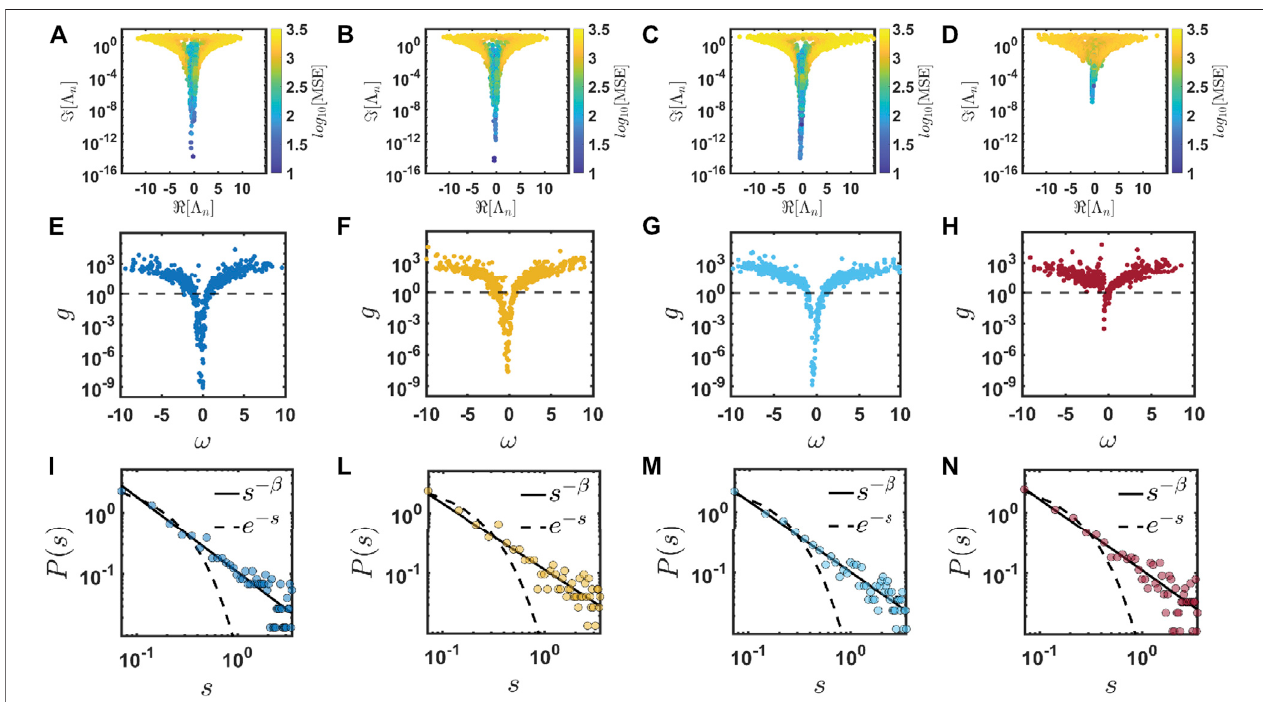
FIGURE7| Complexeigenvaluedistributions,Thoulessnumber,andlevelspacingstatisticsofthesamestructuresanalyzedin Figure6 arereported,respectively, in panels (A – D) , (E – H) , and (I – N) when ρλ 2 (cid:3) 5.5. These data not only show a Thouless number g < 1 at ω ≈ 0, but also show that P ( s ) describes level clustering with a power-lawscaling[continuousblacklines inpanels (I – N) ].ThePoissondistribution thatischaracteristic ofuniformrandomsystemsisalso reportedwithablackdashed line as a comparison.